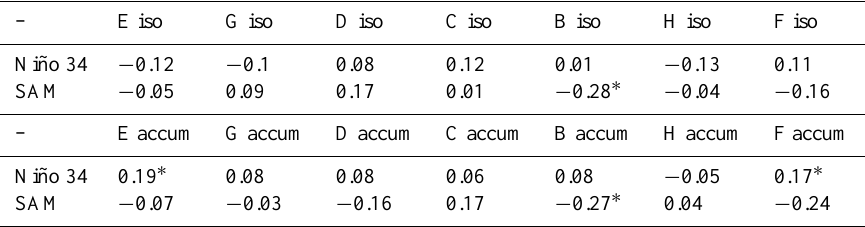
Table 5. Siple Dome correlation values for both water isotope δ D and net accumulation versus either Niño 34 or SAM. Values with a star indicate significant Pearson’s correlation values of less than